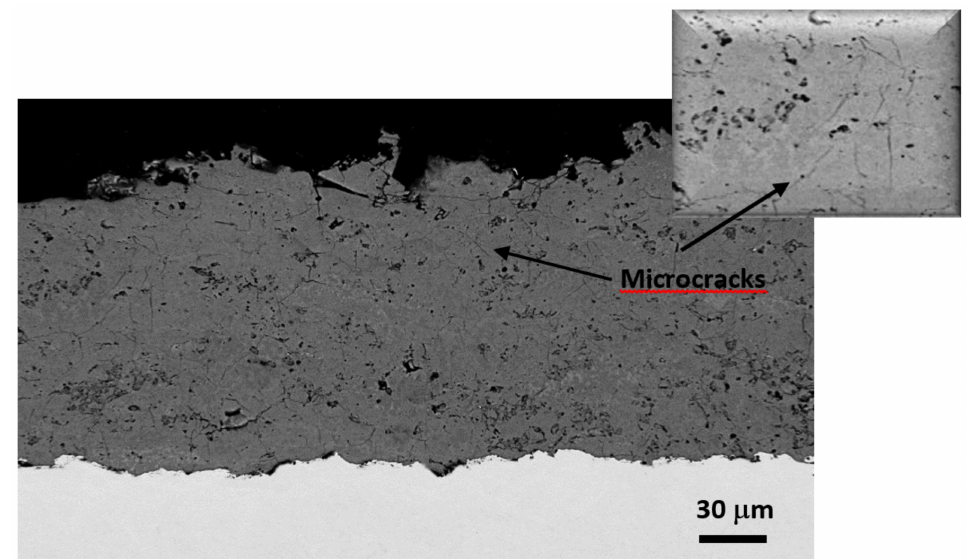
Figure 7. FESEM cross section image of one of a QC coating deposited by